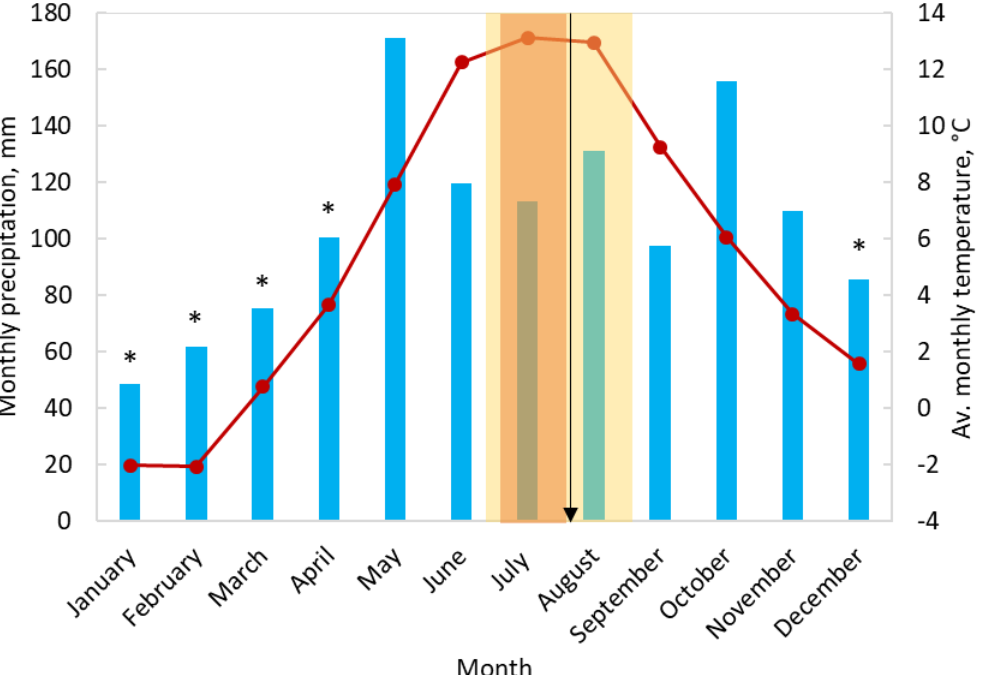
Figure 10. Monthly precipitations and average monthly temperatures measured in meteorological station of Malga Arpaco in the period 2003–2017. Yellow area refers to the grazing period, typically applied for LG patch; orange —for SG patch, arrow indicate a sampling period, “*” indicate months with snow precipitation.